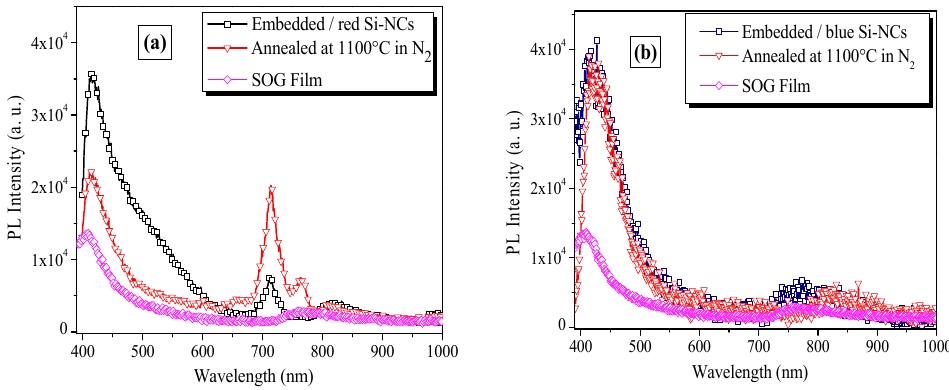
Figure 9. (Color Online) PL emission spectra of embedded films with red ( a ) and blue Si-NCs ( b ) before and after annealing at 1100 °C in N 2 atmosphere. PL spectra from pure SOG films are included.